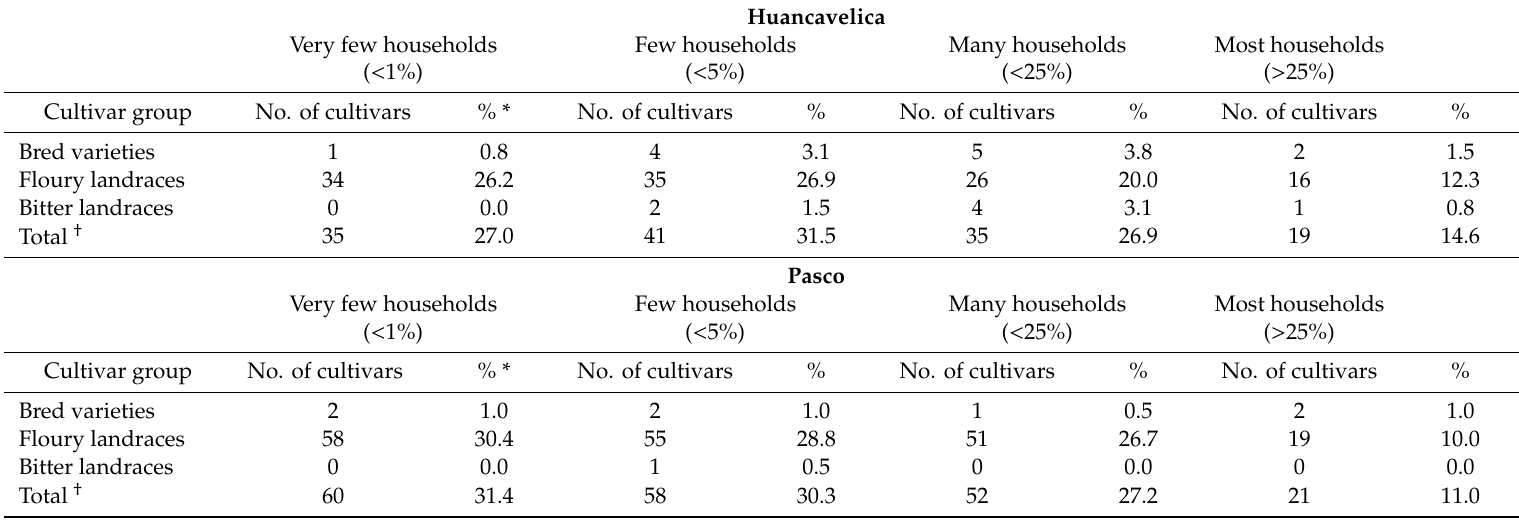
Table 7. Overall cultivar frequencies (OCF) or measure of evenness of unique cultivars by cultivar group and